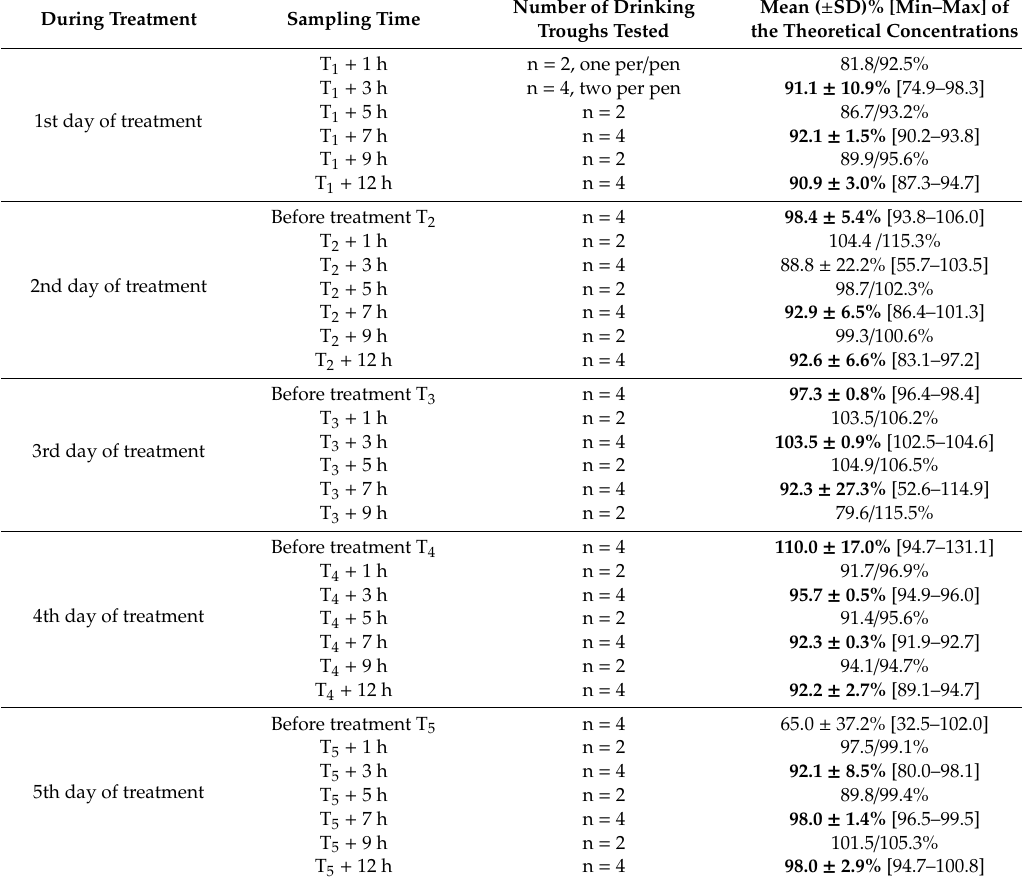
Table 4. Percentage of the theoretical concentrations of SDM found in drinking troughs during the SDM treatment of 200 lambs for 5 days via the drinking water (Emericid ® Sulfadimethoxine, 55.68 mg / kg SDM the 1st day and 27.84 mg / kg / 24 h SDM from the 2nd to the 5th day). Depending on the sampling time, percentages were given as mean ± SD and [range] when water was collected from all the drinking troughs (n = 4, two in two di ff erent pens) and as two separate values when water was collected in only one drinking trough / pen (n = 2). No SDM was found in the drinking troughs as soon as the treatment was stopped and the pipes were flushed (not shown in the